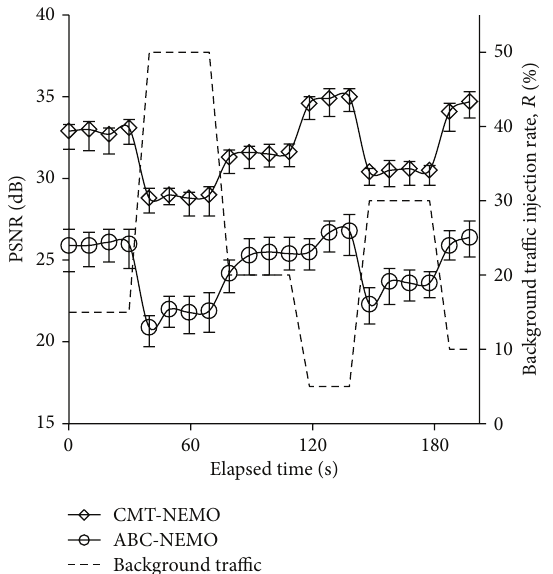
Figure 22: PSNR comparison of how each scheme responds to the injection of background traffic.